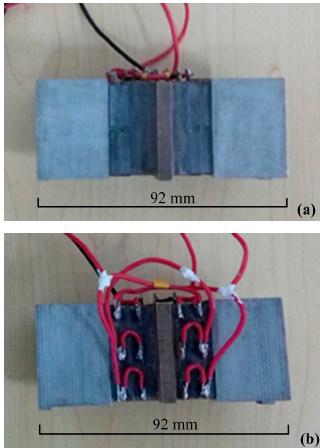
Figure 6. The prototypes of two transducers operating in longitudinal-bending hybrid modes under different exciting methods: ( a ) the one using the traditional exciting method; ( b ) the other one using the new exciting method.